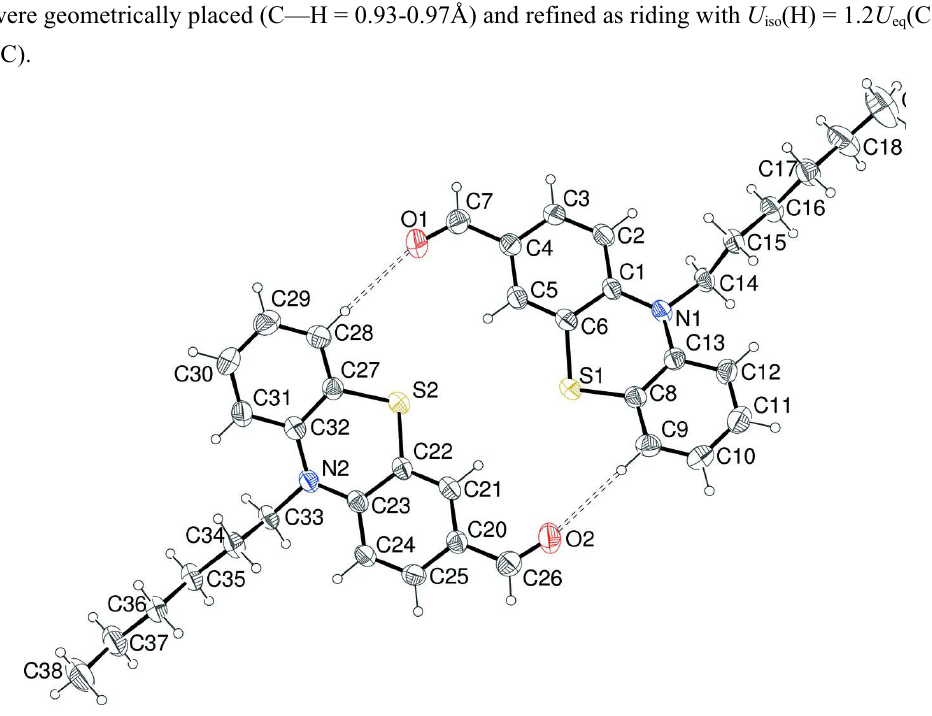
The molecular structure of (I) showing 50% displacement ellipsoids for the non-hydrogen atoms. The hydrogen bonds are indicated by dashed